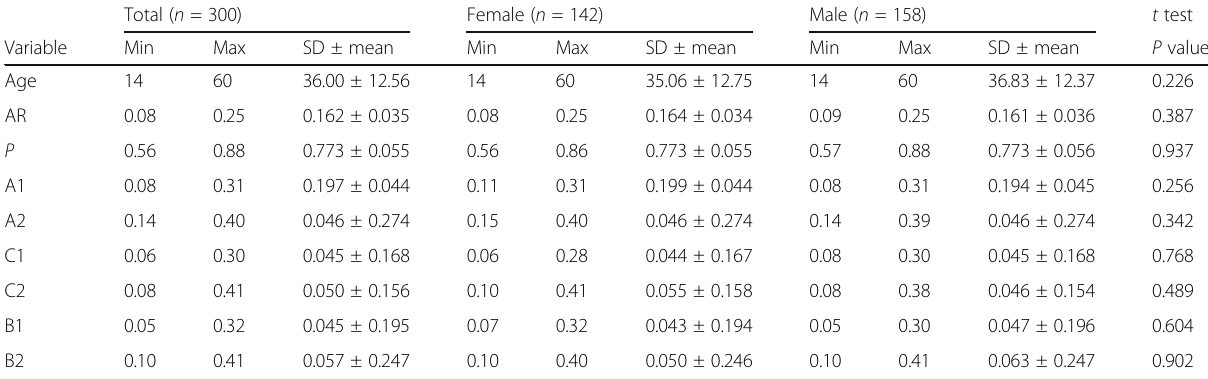
Table 2 Comparison of the mean variables in males and females using t test Total ( n = 300) Female ( n = 142)